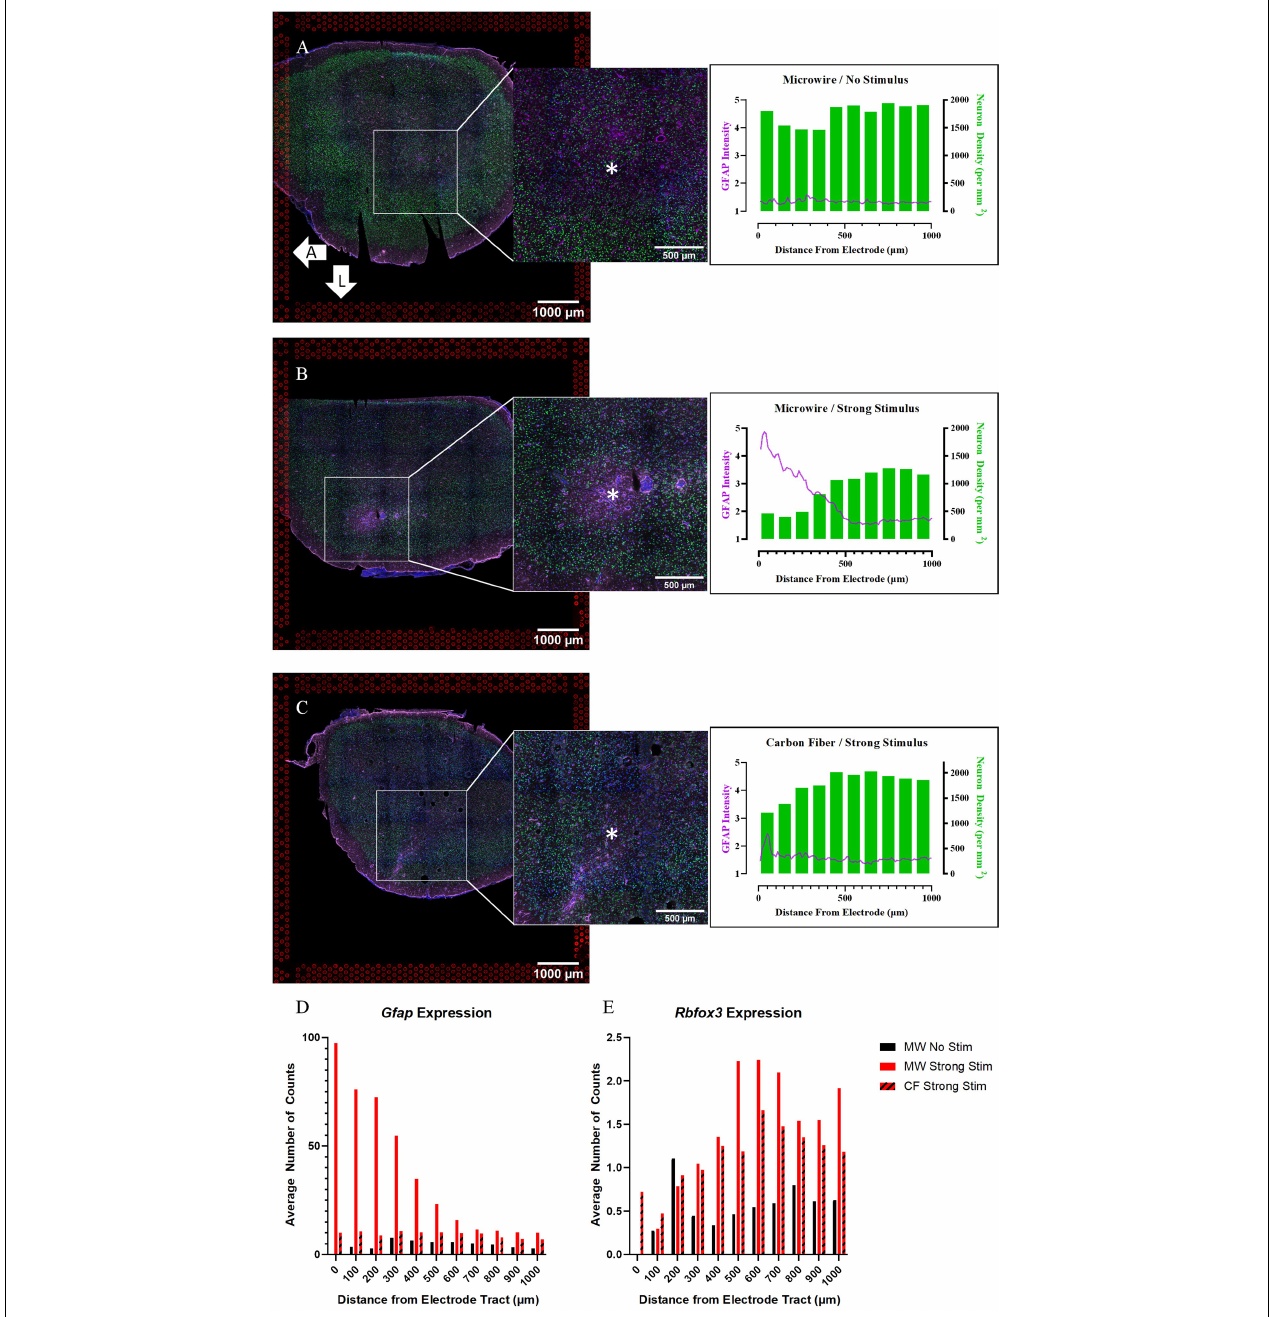
FIGURE 5 | Quantitative immunohistochemistry of chronically implanted samples indicates that both device type and stimulation delivery may influence traditional safety metrics (neuronal density, glial reactivity). (A) Tissue collected at the 4-week time point from a sample implanted with a MWA that delivered no stimulation shows relatively minimal local glial (GFAP) reactivity or neuronal loss (NeuN density). (B) Tissue collected from a sample implanted with a MWA that delivered electrical stimulation following 4 weeks of device implantation shows evidence of local gliosis and neuronal loss. (C) Tissue collected from a sample implanted with a HDCF that delivered electrical stimulation following 4 weeks of device implantation shows lesser evidence of local gliosis and neuronal loss in comparison to the MWA/Stimulation sample shown in panel (B) . (D) Spatial expression of Gfap counts at increasing distances from the electrode tract in all three chronic samples align with IHC results. (E) Spatial expression of the gene Rbfox3 , which encodes the NeuN protein, at increasing distances from the electrode tract in all three chronic samples. An advantage of the spatial transcriptomics assay is that spatial profiles of gene expression can be compared directly with more traditional quantitative immunohistochemistry metrics. Asterisks denote estimated implant site and arrows denote orientation (L: lateral, A: anterior). Scale bars: 1.0 mm.